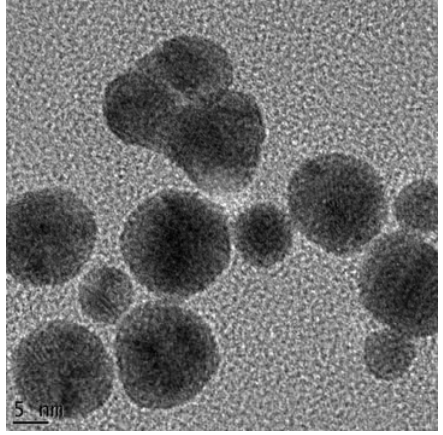
Figure A1. Visualization of carbon dots via transmission electron microscopy (TEM).